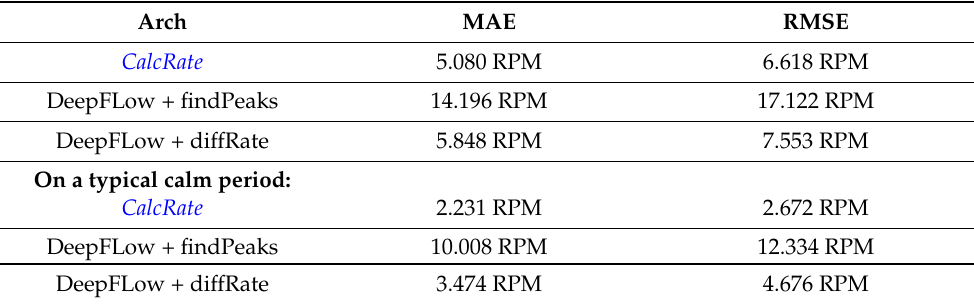
Table 4. Statistical evaluation of the respiration-rates generated by classical (CalcRate) and the DeepFlow-based algorithms. The second and the third rows (DeepFLow) show the results provided by the implementation of the algorithm proposed by [5]. The bottom four lines show the results for some quiet periods when there were moderate limb motions only. The evaluation was performed using moving average where we employed a sliding window of 120 s, the same time window as in the method we compare to [5]. Italic and blue colored typeface denote our method (CalcRate). We applied two kinds of peak detector in the evaluation of the result of the DeepFlow-based algorithm. FindPeaks is a peak detector provided by SciPy, while diffRate is developed by us and based on the detection of points where the curve is crossing the zero line. As we can see, the type of peak detection method has a big effect on the result. Arch MAE RMSE